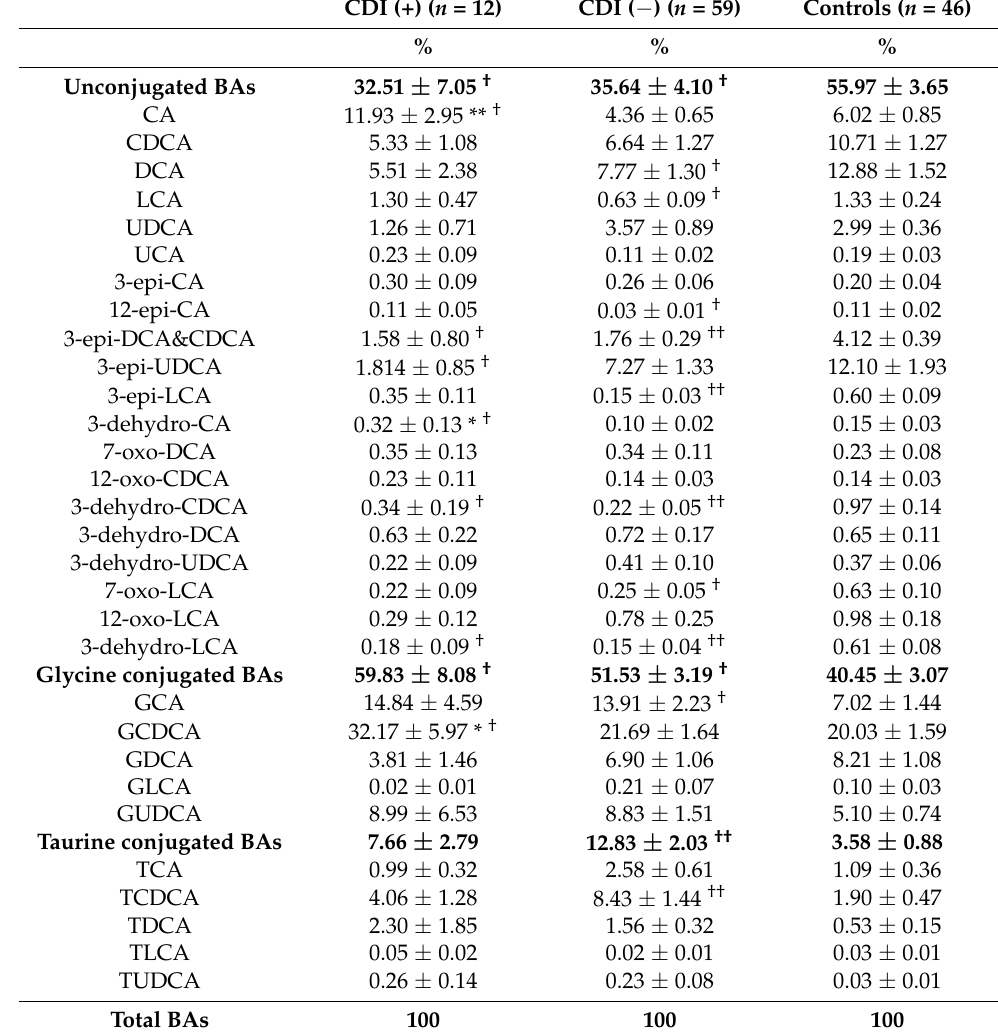
Table 2. Serum BA composition in subjects with and without Clostridium difficile infection